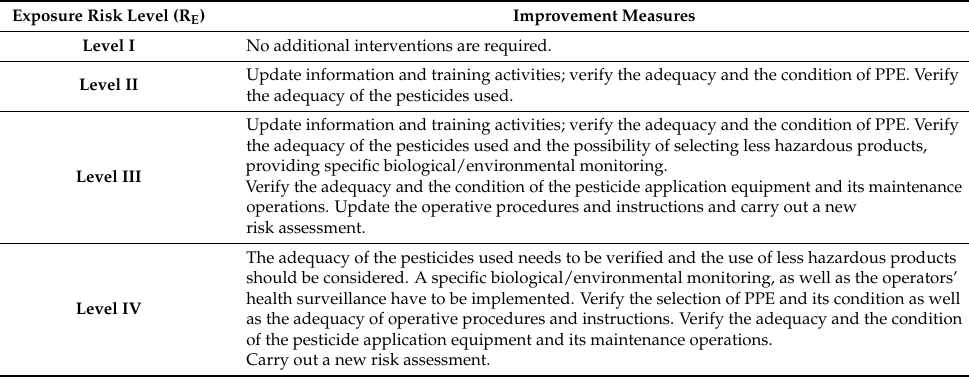
Table 11. Improvement measures depending on the exposure risk’s